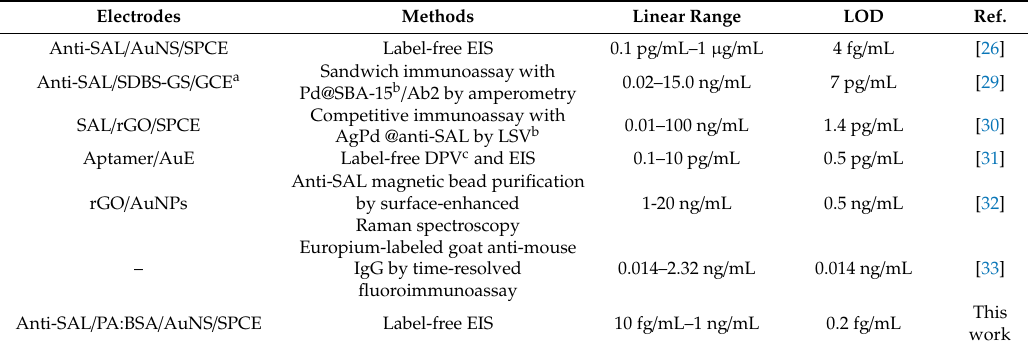
Table 2. Comparison of the sensing properties of di ff erent immunosensors for the detection of SAL.